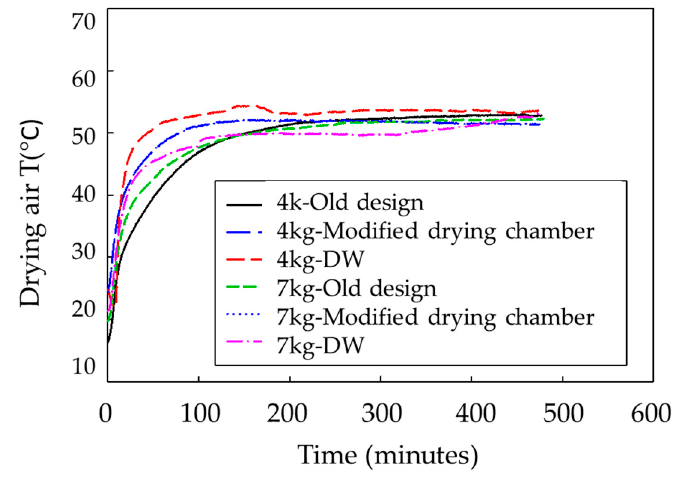
Figure 6. Variation in the drying air temperature at the dryer inlet.